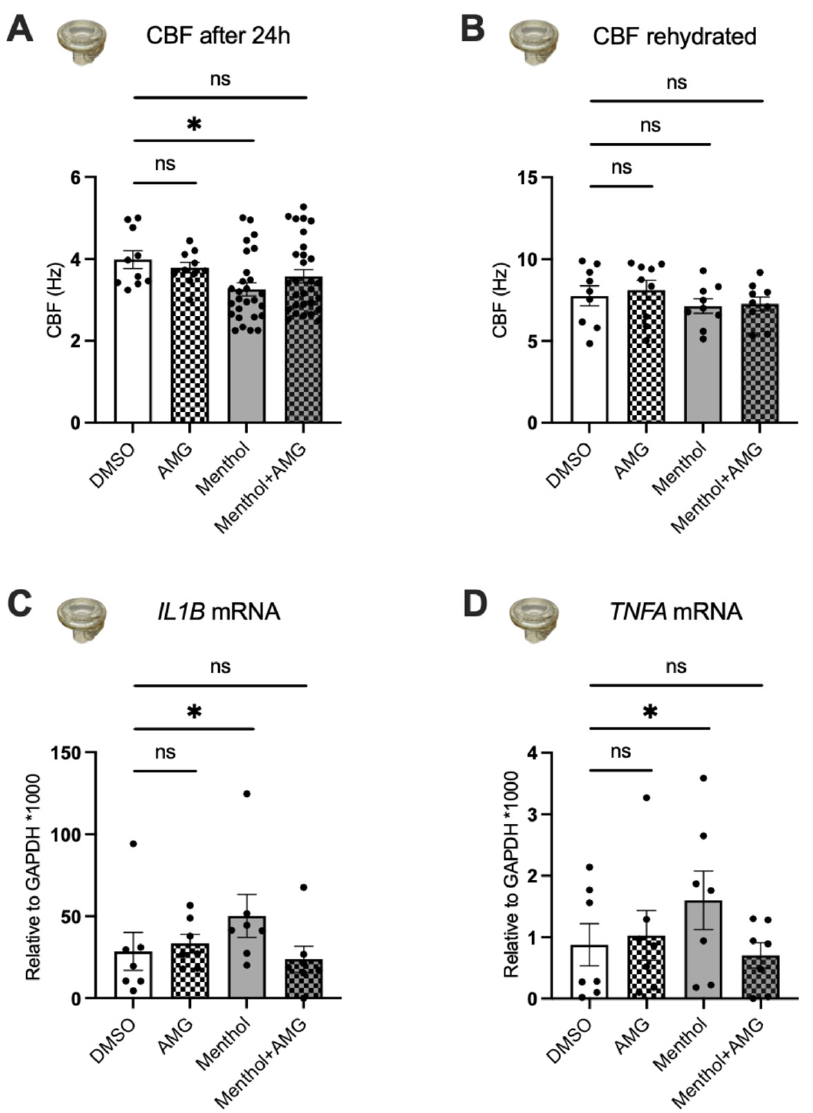
Figure 5. Effects of a TRPM8 antagonist on menthol-induced reductions in CBF and increases in IL1B and TNFA mRNA expressions. All assays were recorded 24 h after nebulization of DMSO (~0.1% final in the ASL, control) and menthol (~1 mM) with or without AMG333 (~100 nM final in the ASL and 100 nM in the basolateral media). ( A ) CBF measurements after nebulization of menthol and AMG333. N = 10–29, 2–6 lungs. ( B ) CBF measurements after rehydrating the surface of cultures with PBS. N = 9, 3 lungs. ( C , D ) Expression levels of IL1B ( C ) and TNFA ( D ) mRNAs. N = 7, 3 lungs. Statistics: Data shown as mean ± SEM. * p < 0.05 compared to DMSO control, two–way ANOVA followed by Dunnett ( A , B ) and one–way ANOVA followed by Dunnett ( C , D